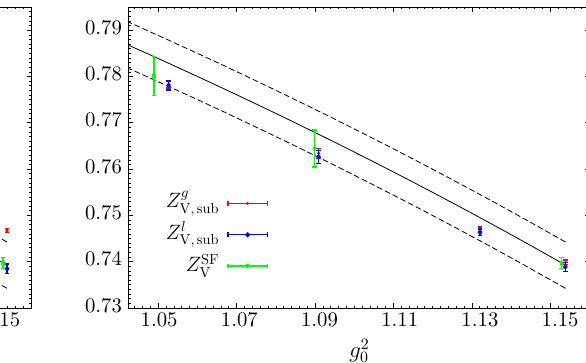
Fig. 4 Comparison of different Z V determinations for N f = 2, obtained from WIs in the standard SF and from universality relations in the χ SF. The effect of the perturbative one-loop improvement of the χ SF results is also shown (right panel). The χ SF results are those of Table 4. The individual SF points are taken from Refs. [21], and are slightly displaced on the x -axis for better clarity. The solid black line